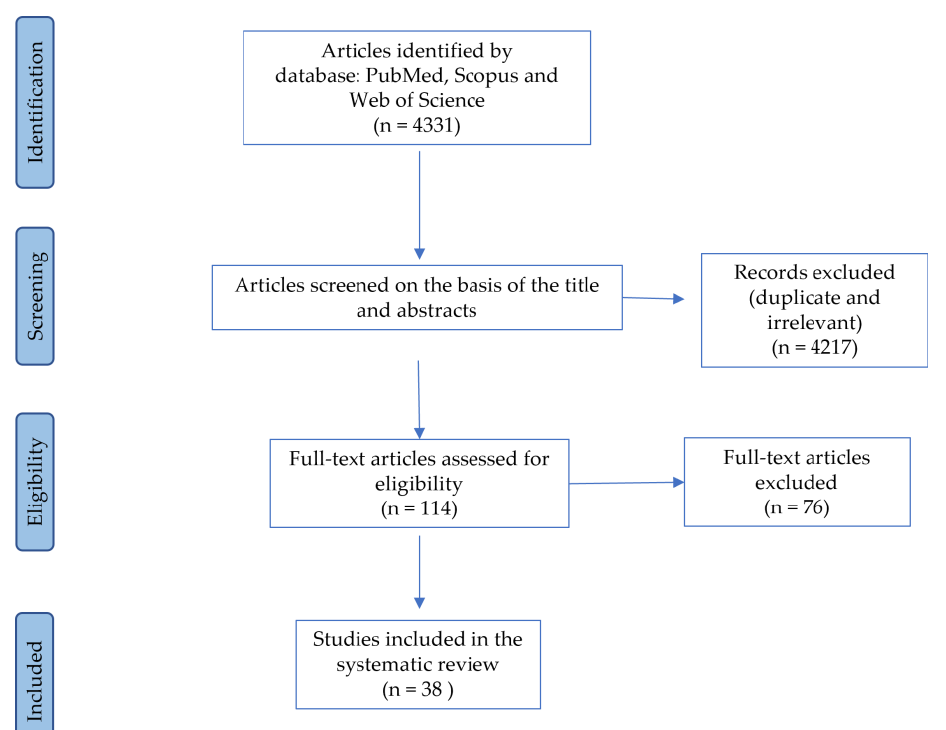
Figure 1. Flow diagram of the steps followed in the search strategy.